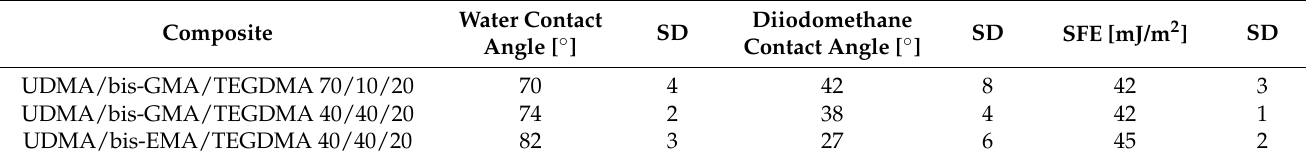
Table 5. Water and diiodomethane contact angle and surface free energy (SFE) of tested composites.